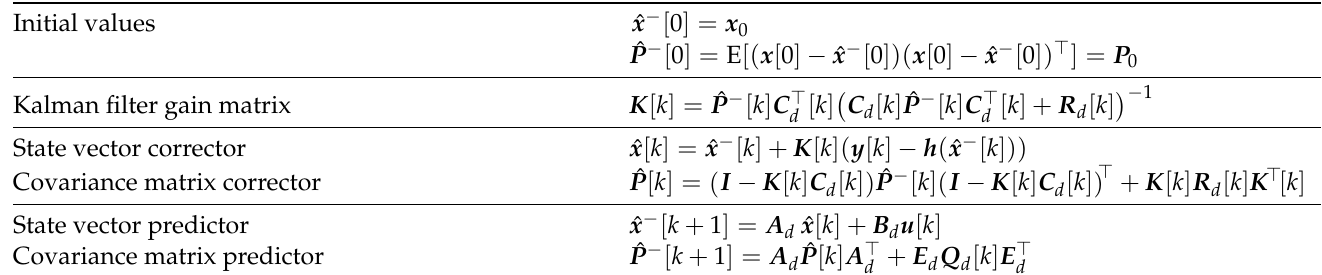
Table 1. Discrete-time EKF for SOG, COG, and course rate